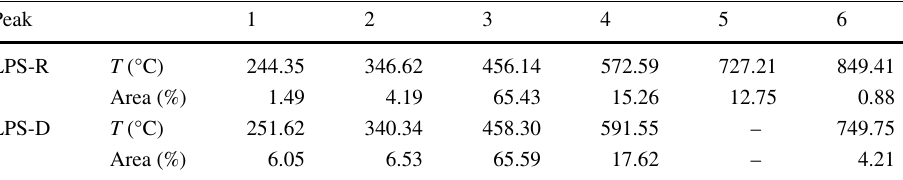
Table 9 The isoconversional methods used in this study